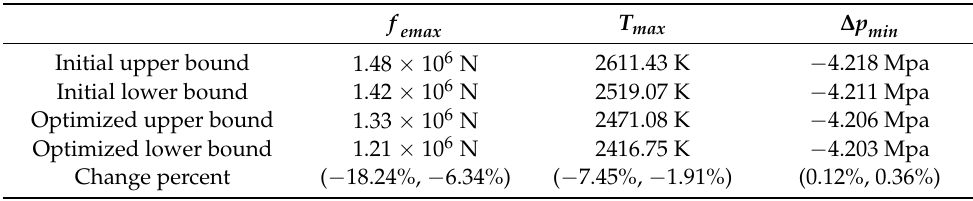
Table 7. Detailed performance evaluation indexes of point